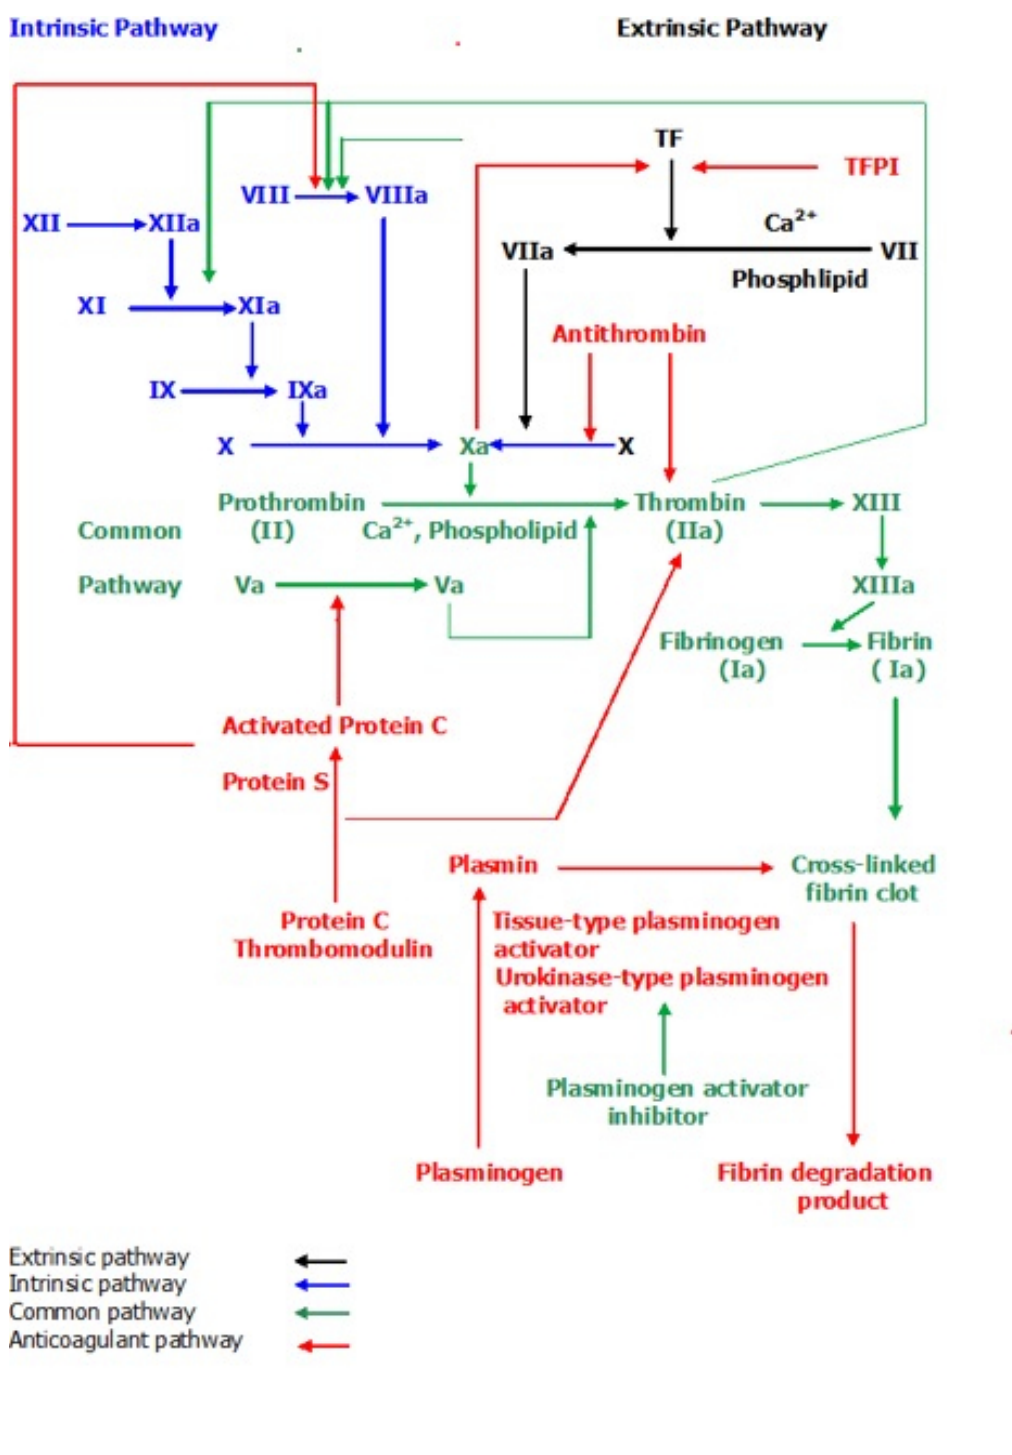
Figure 1. The coagulation cascade